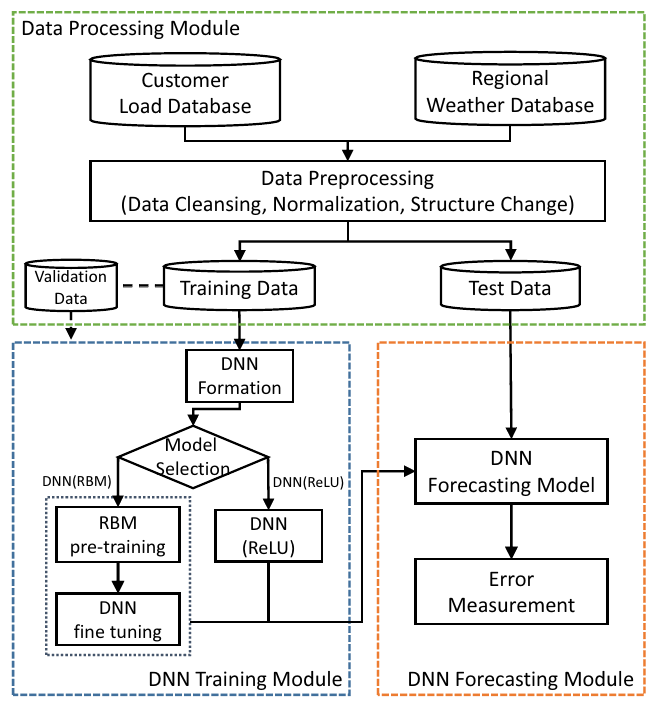
Figure 5. The proposed deep neural network (DNN) short-term load forecasting